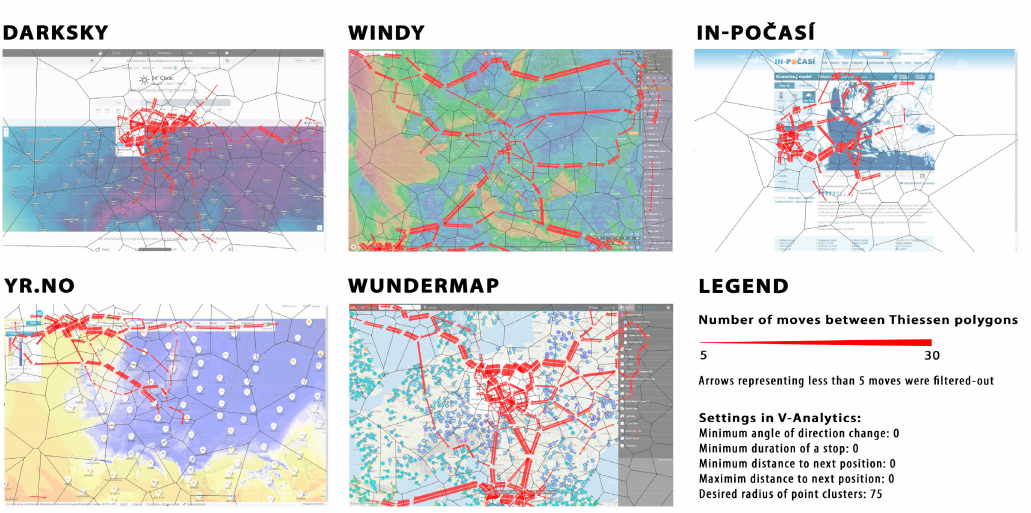
Figure 15. FlowMap analysis of evaluated web maps. The visualization displays aggregated eye-movements of all respondents as arrows between generated Thiessen